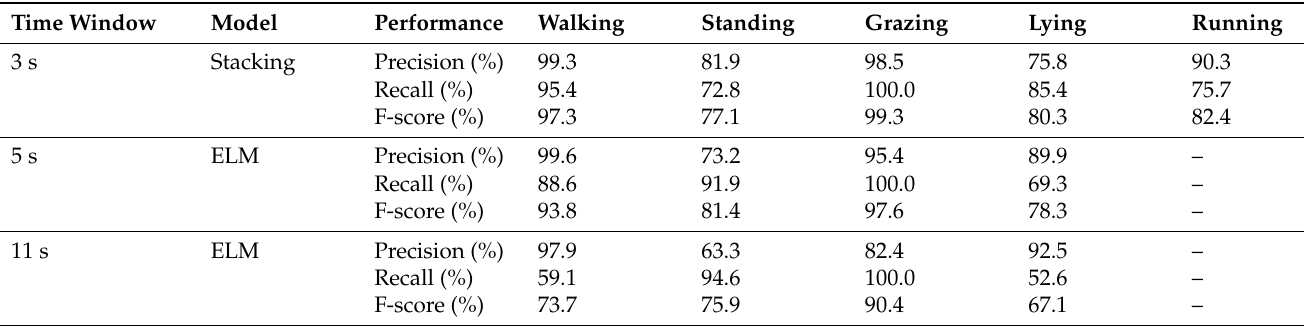
Table 7. Performance statistics of three optimal ML models (with the highest classification accuracy at the 3, 5 and 11 s time window on the CBS test dataset) used for classifying walking, standing, grazing, lying and running on the CBS test dataset.